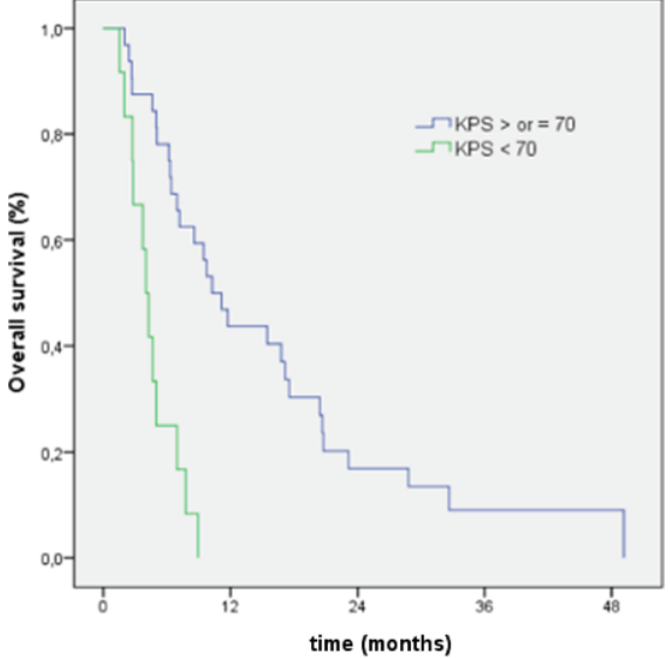
Figure 2. Overall survival curves of patients according to Karnofsky performance score